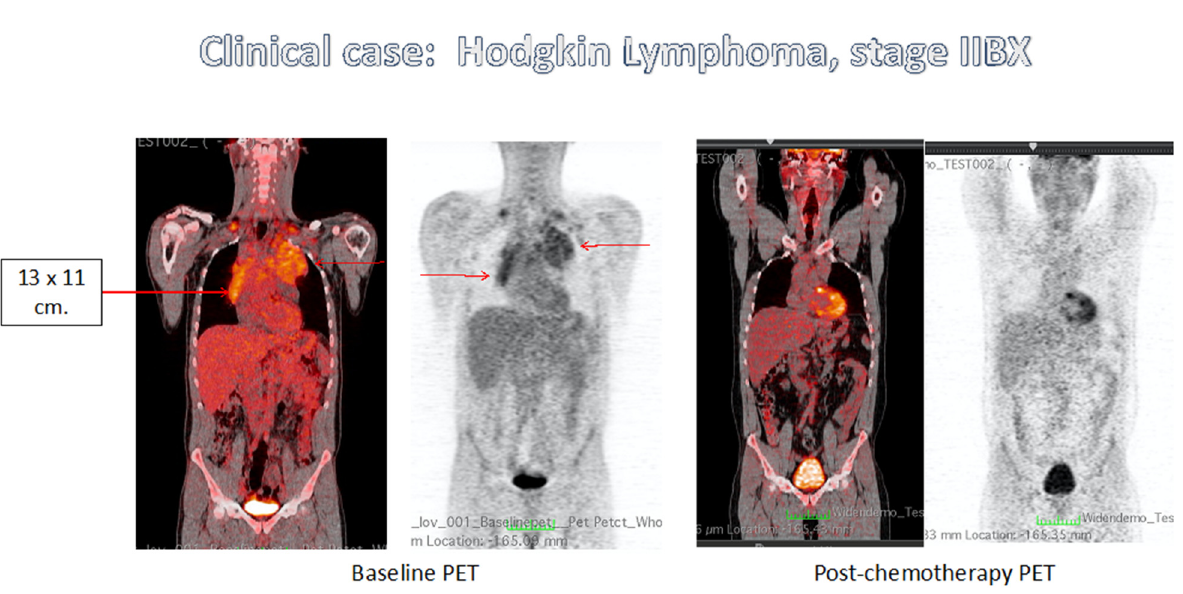
Figure 1. C.M., male, aged 38 years, admitted for evening fever >38 ◦ C, night sweats, weight loss > 10 kg, cough, and enlarged cervical and supraclavicular nodes. On CT scan, a classic mediastinal bulky with a size of 13 ×11 cm was detected. Hemoglobin was 11.9 gr/dL, WBC 11,060 × 10 9 /L, Neutrophils 75%, Lymphocytes 15.6%, platelets 381 × 10 9 /L, LDH 287 U/L (NV: < 460 UI/L). The Bone Marrow Biopsy was negative. The patient was in stage IIB X, with an IPS score of 2 (male, albumin < 4 gr/dL). The patient was enrolled in the HD 0607 clinical trial and treated with two ABVD cycles, with complete resolution of symptoms. A chest CT scan after two ABVD cycles showed a persisting mass of 6.2 × 4.4 cm and PET/CT was negative. The patient continued with ABVD for four further cycles, while still asymptomatic. A second chest CT scan after six ABVD cycles showed a persisting mass of 6 × 4.2 cm, and the EoT PET/CT was negative. The patient entered the randomized study of consolidation RT Vs. No Further Treatment (NFT), and he was randomized to NFT. Permission was obtained from Prof. Corrado Tarella on behalf of Italian lymphoma group GITIL (Gruppo Terapie Innovative nei Linfomi).